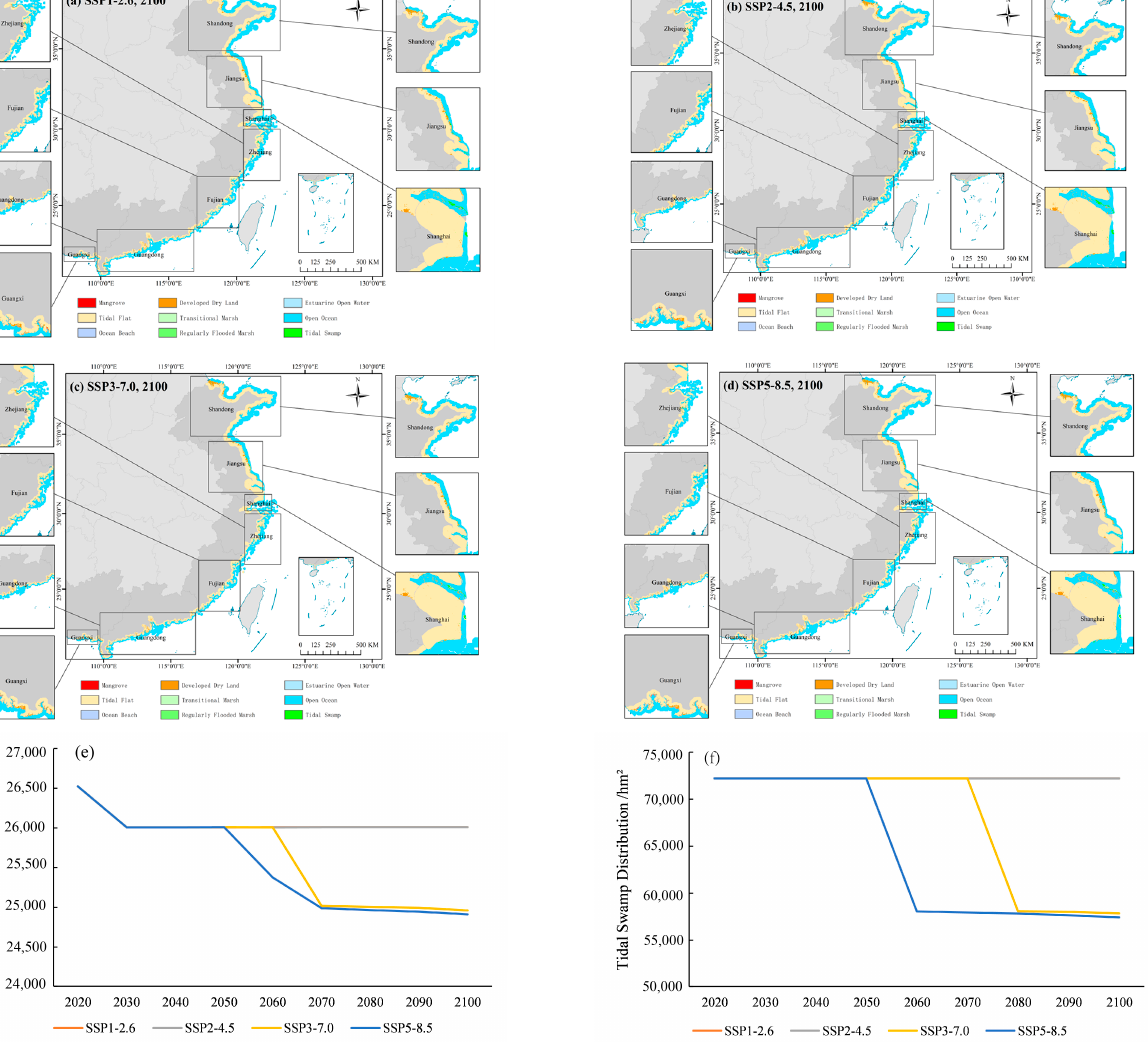
Figure 3. Dynamic changes in coastal China under 4 SLR scenarios. ( e ): the mangrove distribution areas at different scenarios. ( f ) the tidal swamp distribution areas at different scenarios.